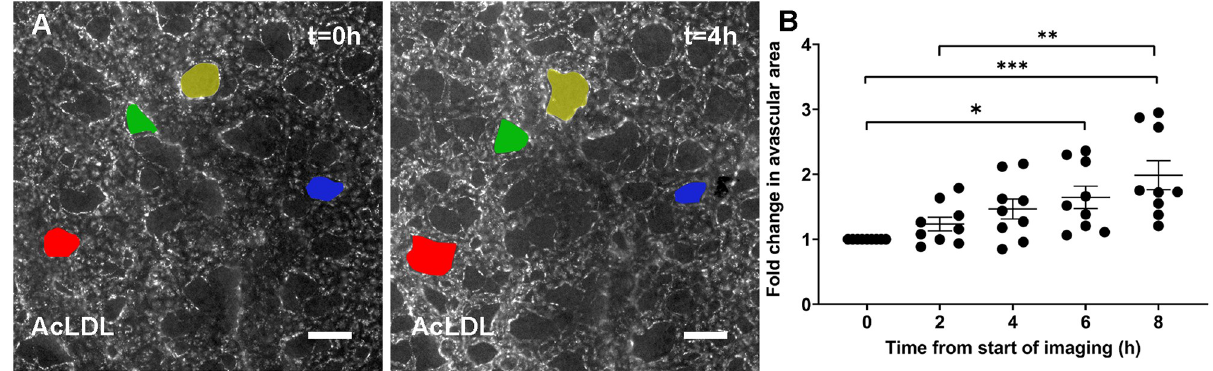
Fig 3. Role of avascular growth in vascular remodelling. A) Fluorescent microscopy images of quail embryo indicating avascular area change (coloured) over time. Blood vessels are labelled by injection of fluorescently labelled acetylated low-density lipoprotein (AcLDL) and unlabled areas are avascular regions. B) Quantitative analysis of the mean change in avascular area (n = 9 embryos). Values are mean ± SEM. Significance is calculated by one-way ANOVA with Tukey’s test. � P < 0.05, �� < 0.01, and ��� < 0.001. Scale bar = 100 μm .